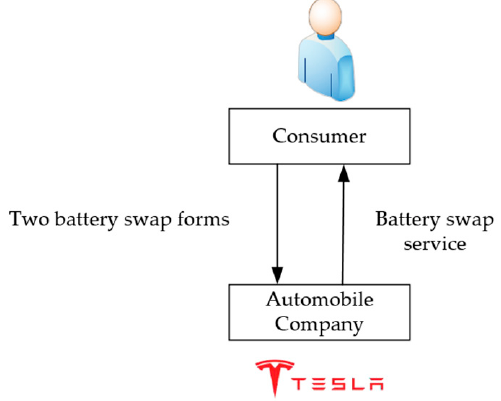
Figure 6. Battery swapping business model of Tesla.